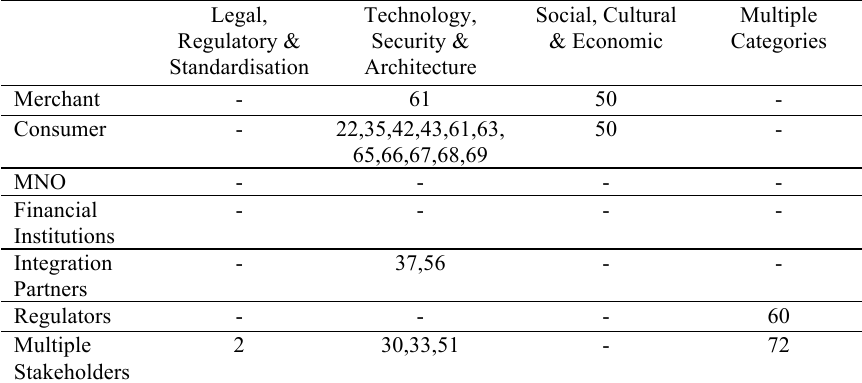
Table 5. Classification of the 20 most recently published papers between 2013 and 2014 Legal,